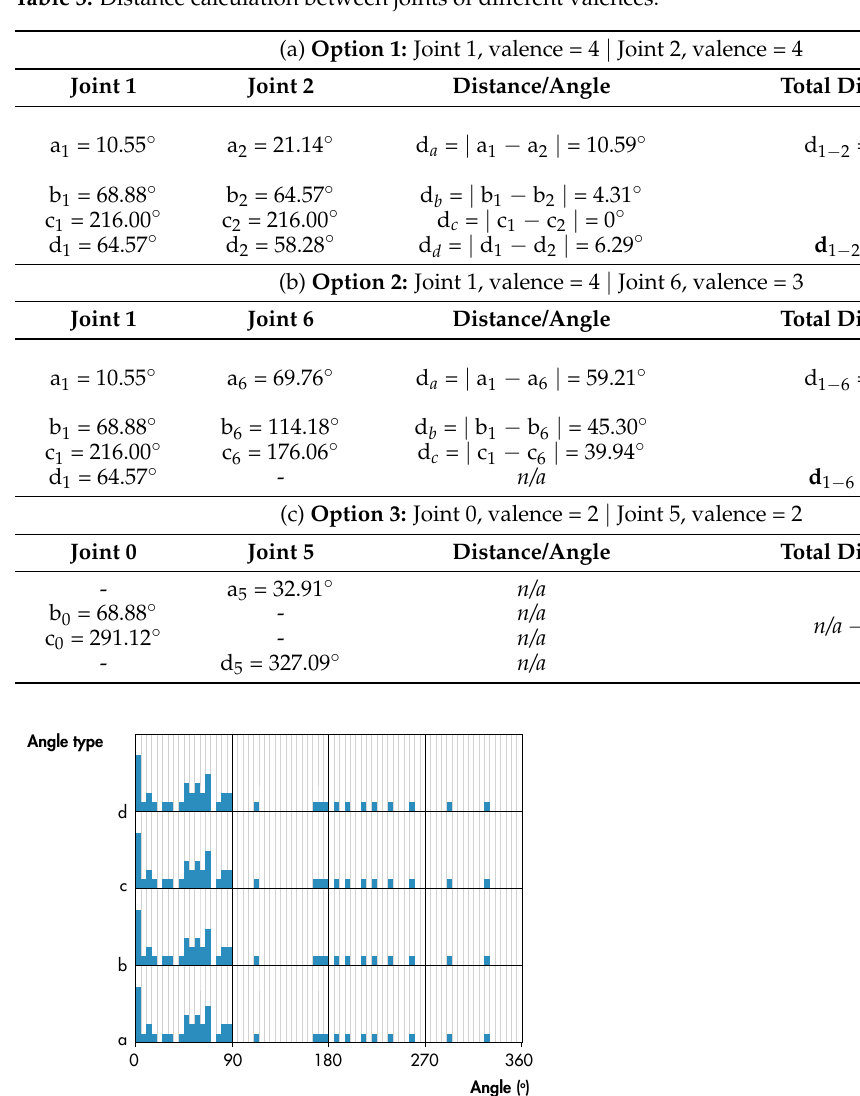
Figure 5. Frequency histogram of the density distribution of the structure’s joint